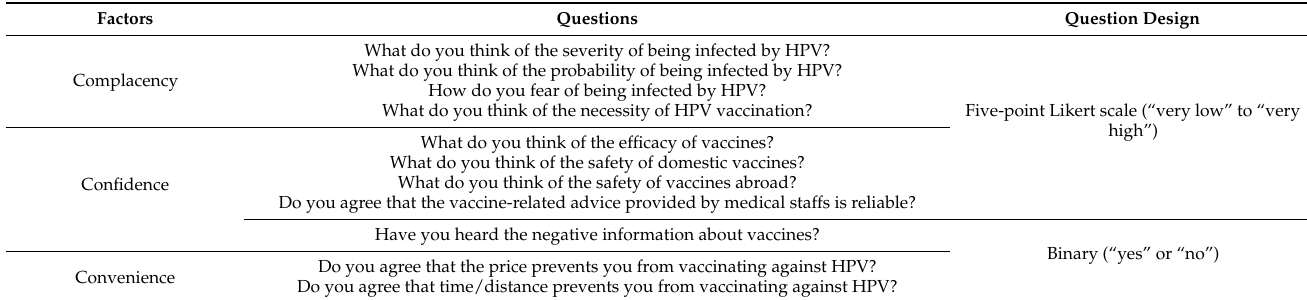
Table 1. Questions used to measure “3Cs” factors in survey